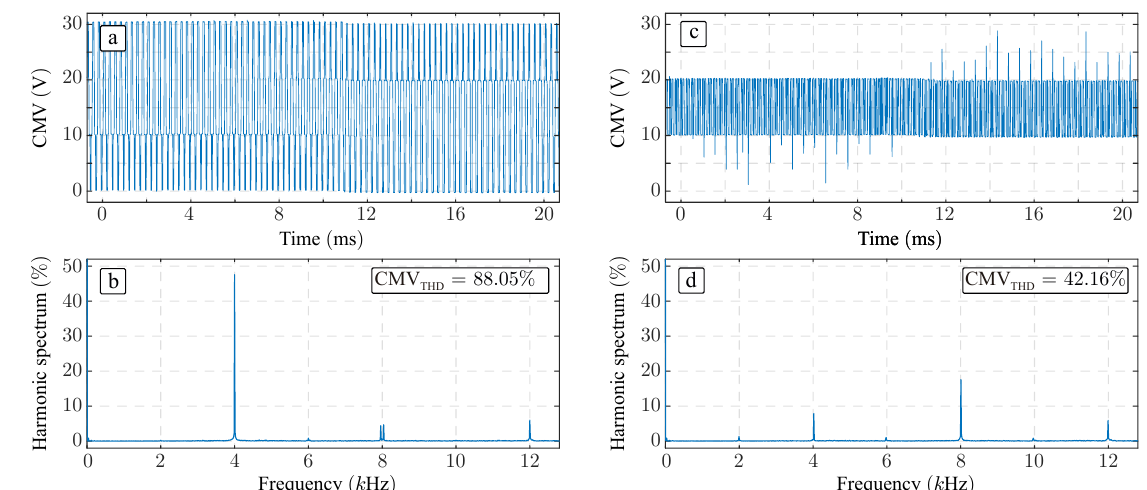
Figure 13. Results applying the traditional PWM method with [ φ a , φ b , φ c ] = [ 0,0,0 ] ◦ ( a ) CMV generated in the PMSM ( b ) CMV harmonic spectrum. Results applying the PWM method with [ φ a , φ b , φ c ] = [ 0,120,240 ] ◦ ( c ) CMV generated in the PMSM ( d ) CMV harmonic spectrum.